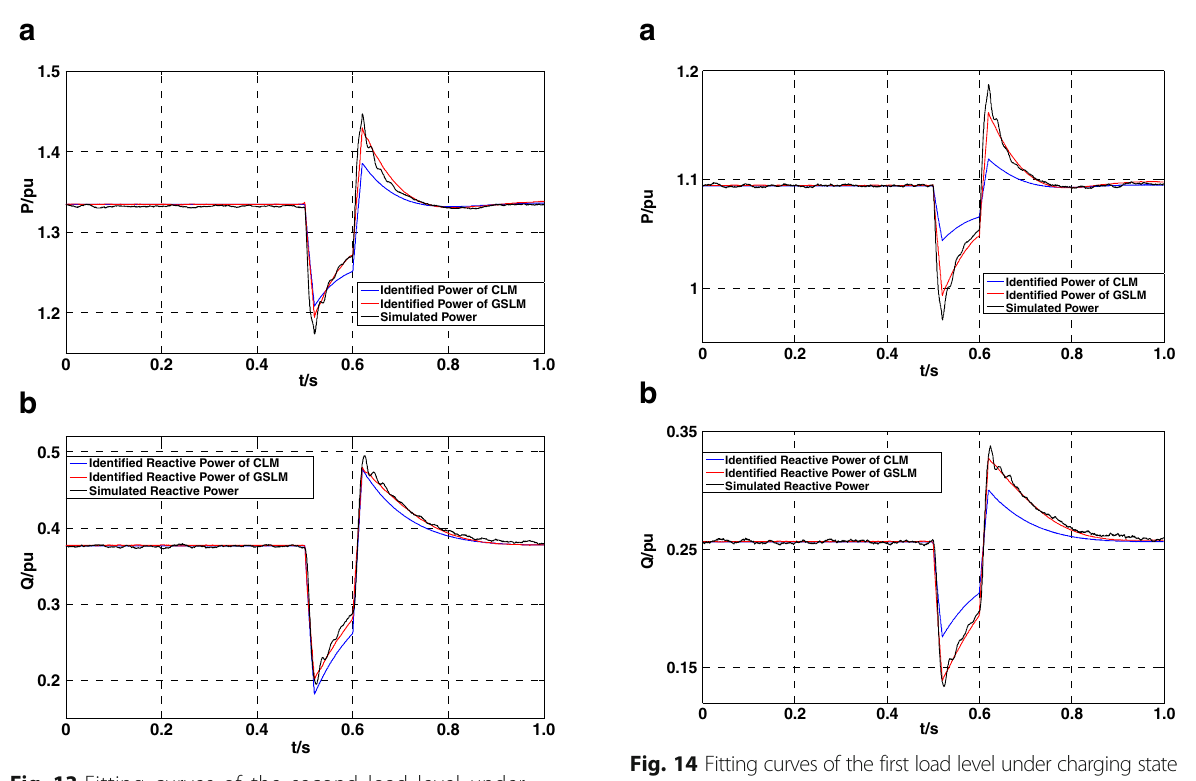
Fig. 13 Fitting curves of the second load level under charging